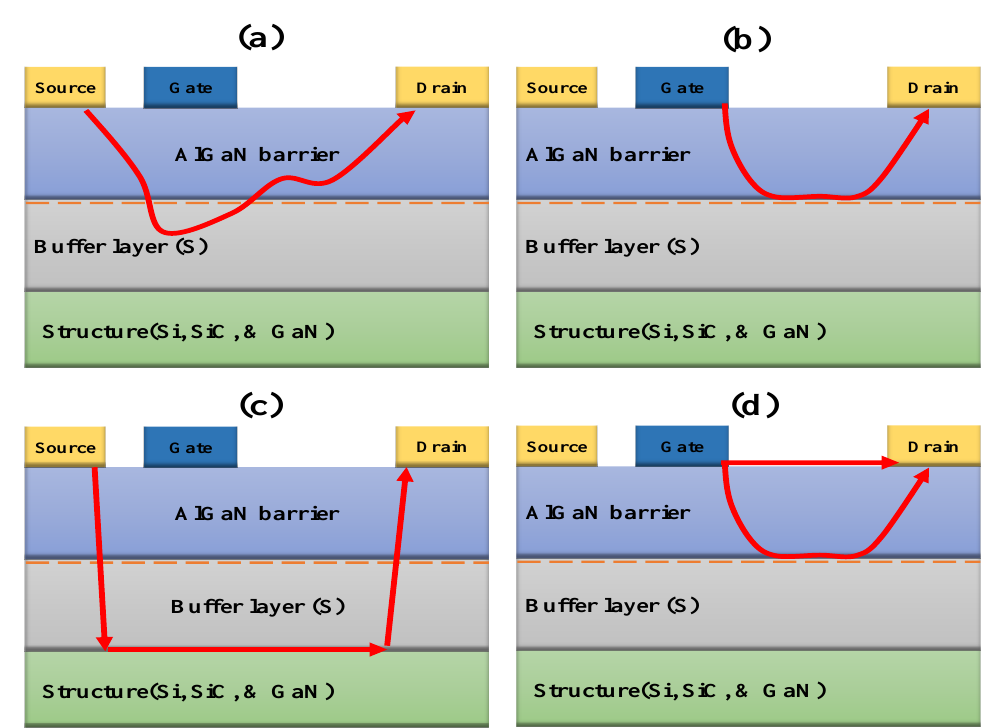
Figure 41. Schematic represents the main source of limiting the high voltage capability of Al- GaN/GaN HEMT on substrates (Si, SiC, or GaN). ( a ) Punch through effect, ( b ) Breakdown along channel region, ( c ) Breakdown through buffer layer, ( d ) Leakage currents originating from the gate structure.